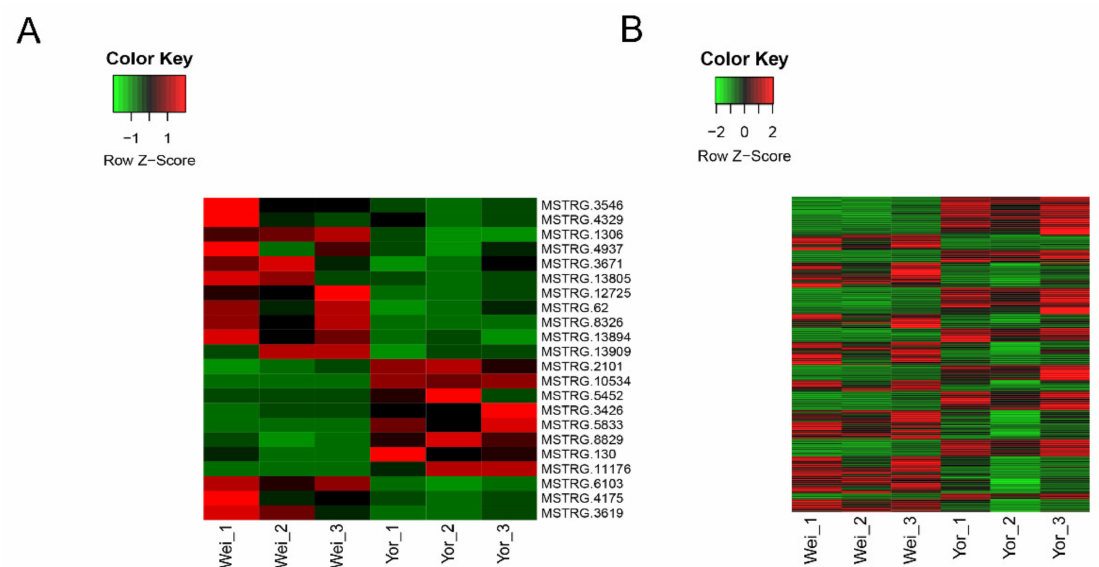
Figure 3. Di ff erential expression analysis of lincRNAs and protein-coding genes in two pig breeds, (Wei) Wei pig and (Yor) Yorkshire pig. ( A ) 22 di ff erentially expressed lincRNAs between the Wei group and Yorkshire group; ( B ) 591 di ff erentially expressed protein-coding genes between the Wei group and Yorkshire